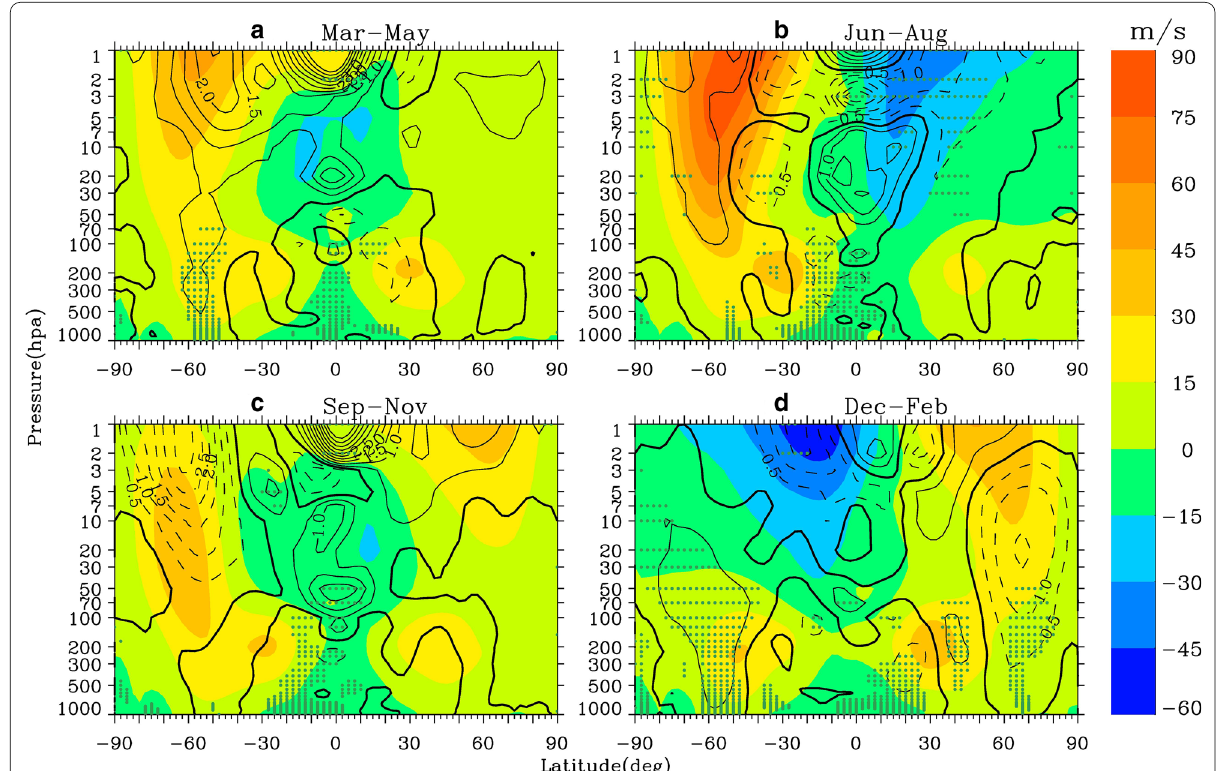
Fig. 9 Trend (contours, units: m/s/decade) of the monthly mean zonal wind in four seasons derived from the 39 year ERA-Interim zonal wind set. The solid and dashed contours denote the positive and negative trends, respectively. The thick black contour represents the 0 value. The stippled regions represent the trends at/above the 95% confidence level. The colors represent the climatological mean of seasonal zonal